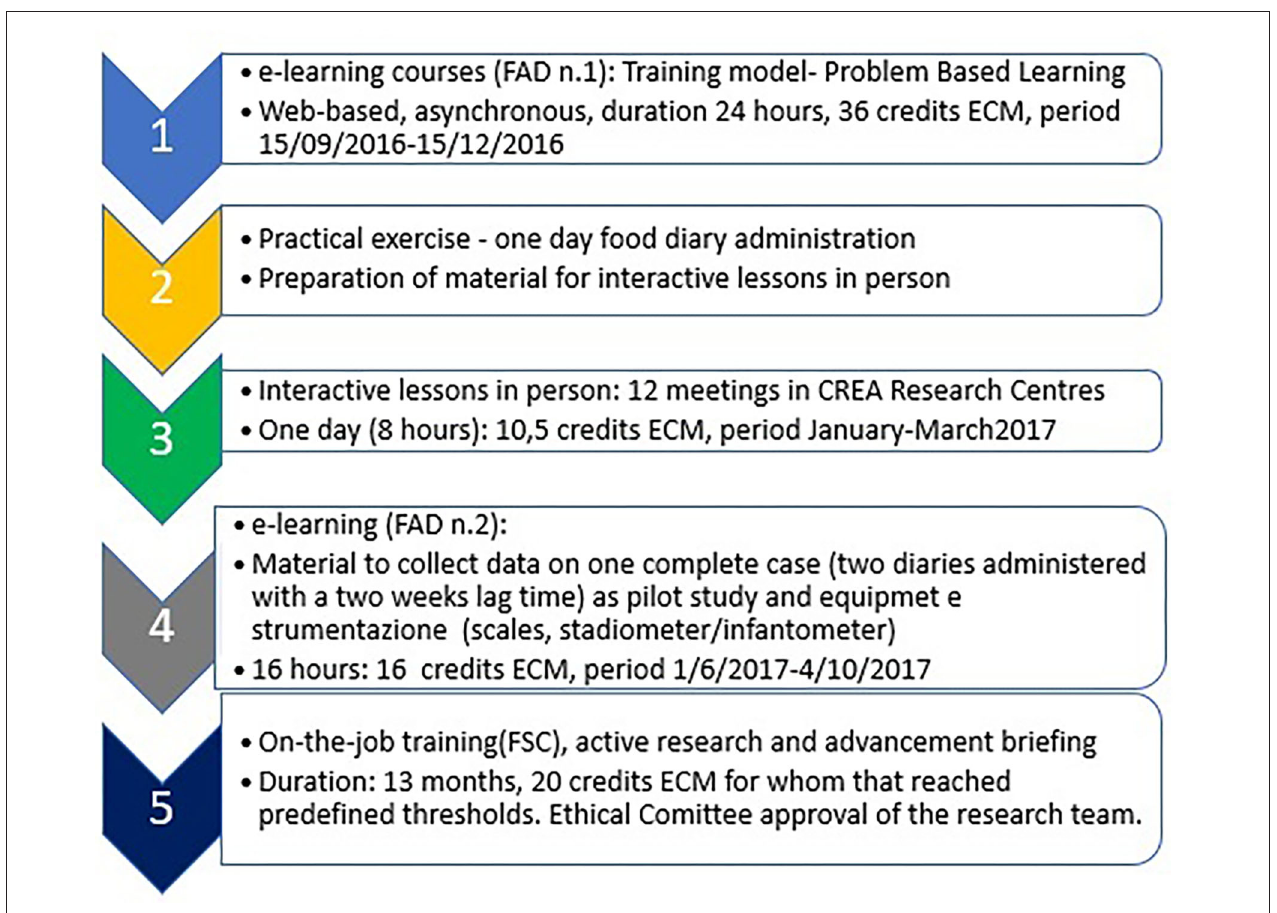
FIGURE 4 | Flow chart course